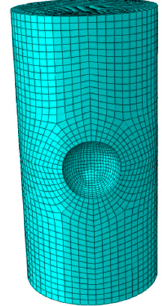
Figure 13. Steel strand grid.